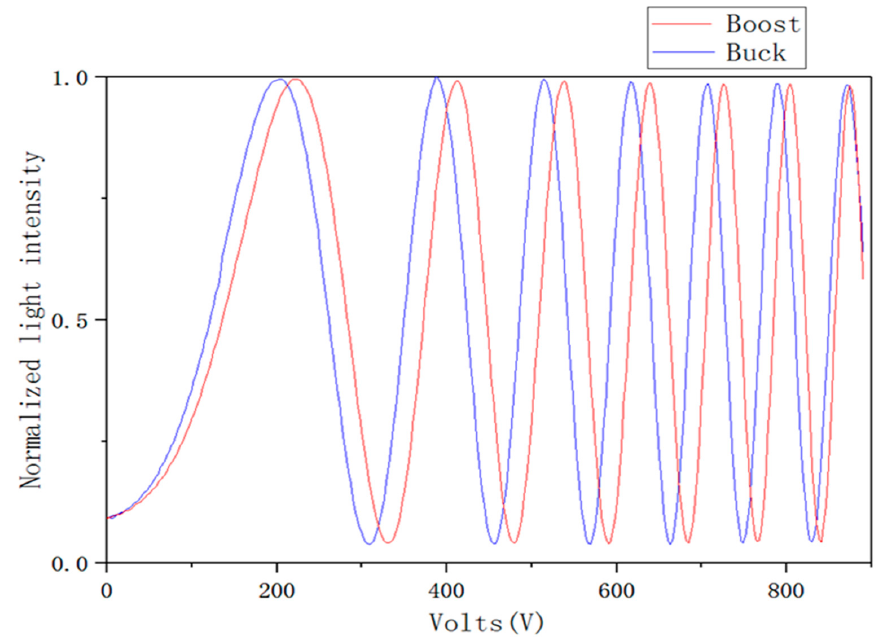
Figure 5. Curve of light intensity modulation when a sinusoidal voltage of 0 to 900 V is applied at 17 °C.